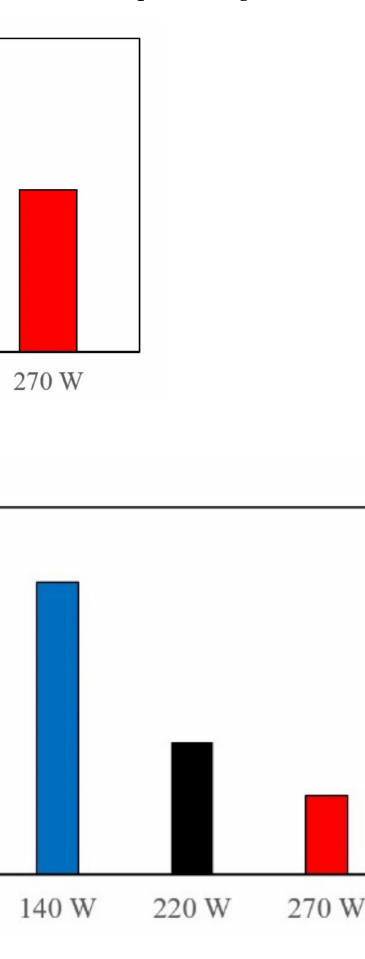
Figure 28. Effect of laser power on ( a ) temperature gradient and ( b ) CR at 650 mm/s and 0.12